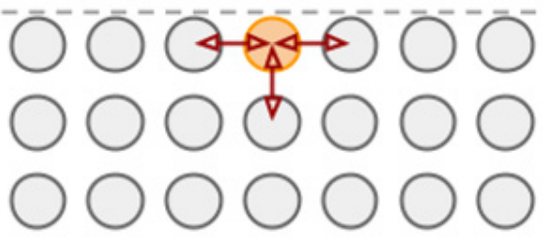
Figure 2. Atoms on the surface of a metal.